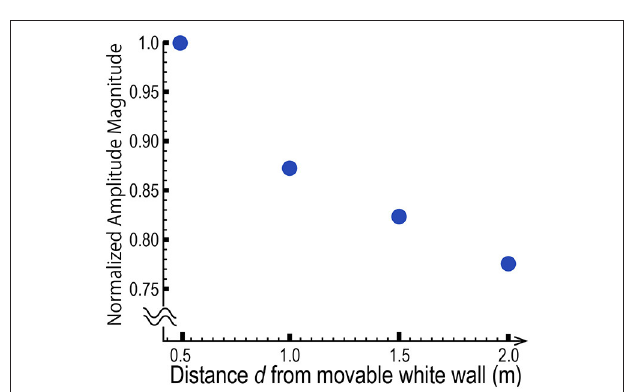
FIGURE 10 | Influence of reflected light via wall at different distances.